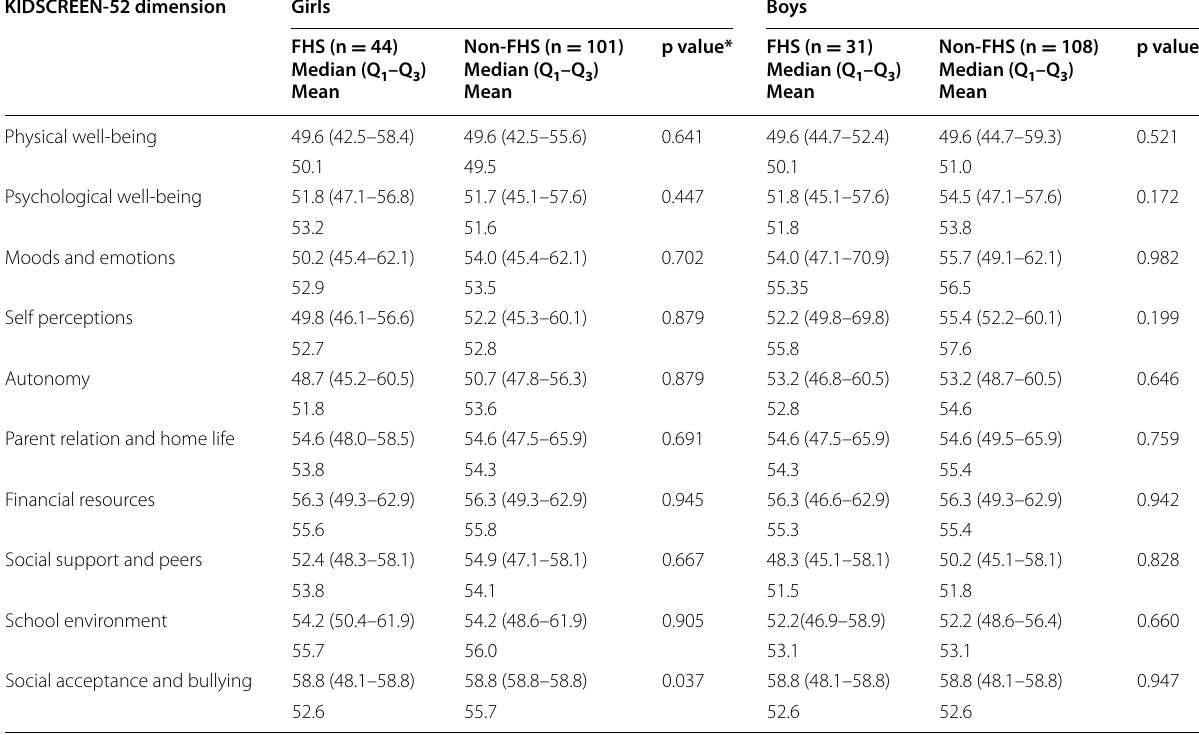
Table 2 Scores in KIDSCREEN-52 domains among girls and boys, with and without food hypersensitivity,